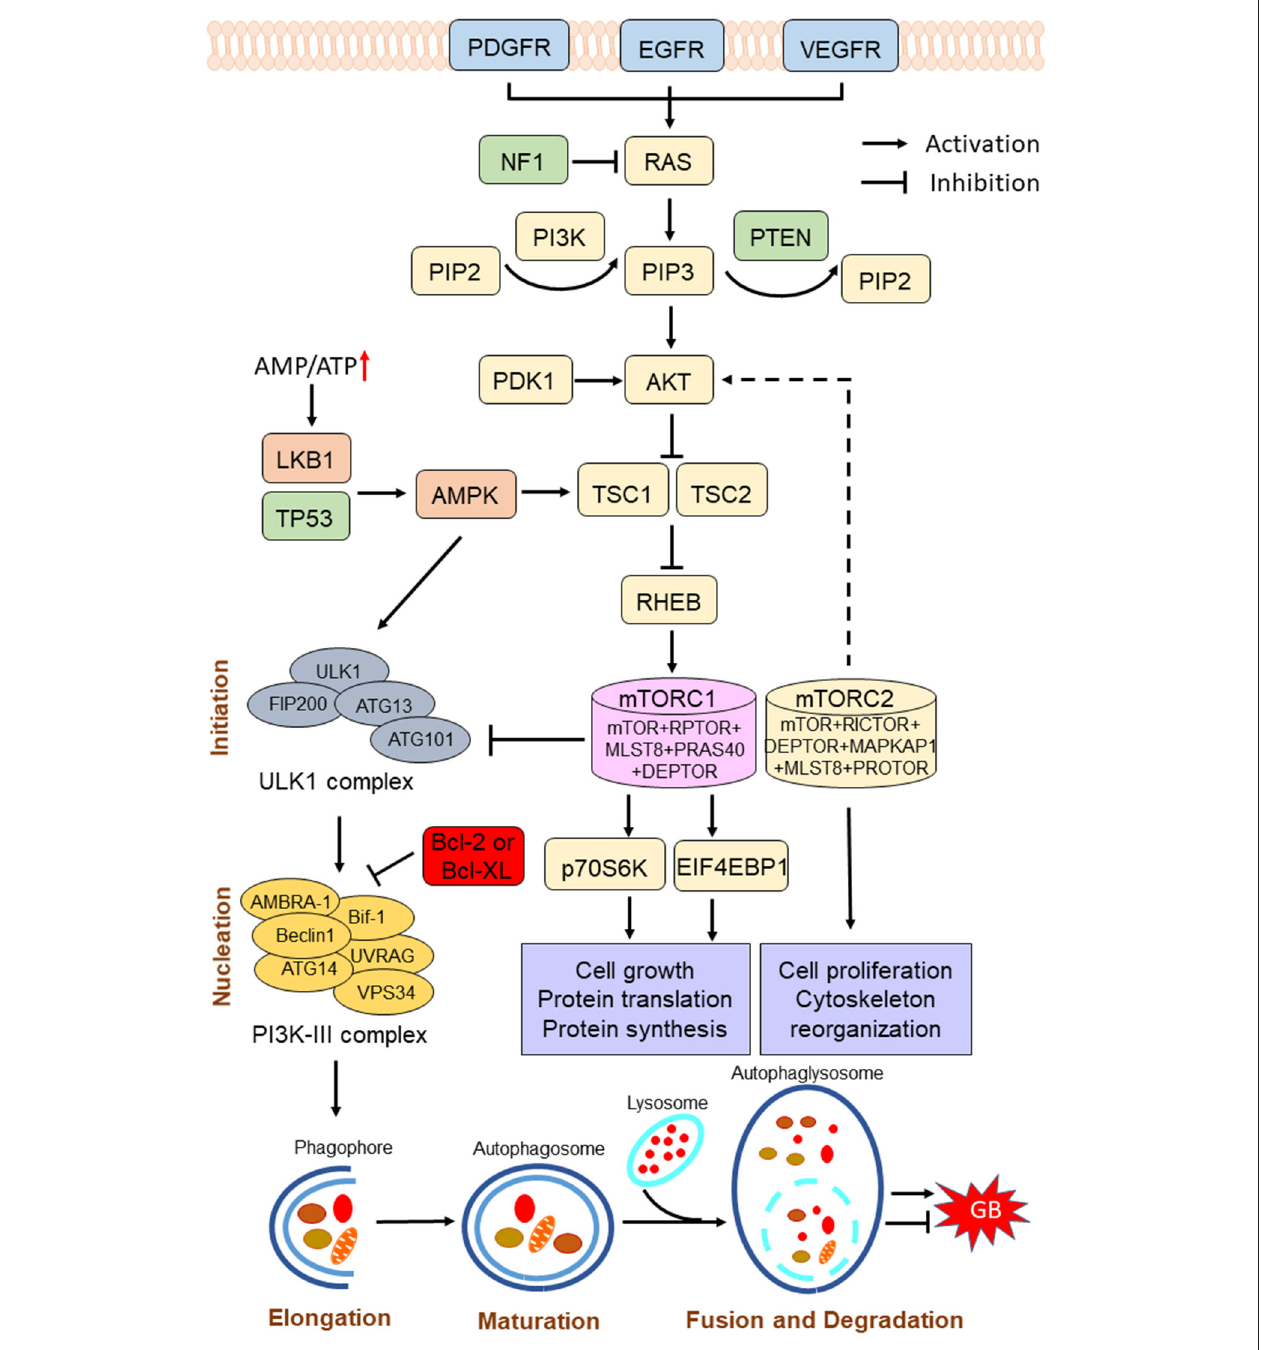
FIGURE 1 | Scheme of the phosphoinositide 3-kinase (PI3K)/protein kinase B (AKT)/mammalian target of rapamycin (mTOR) pathway in the regulation of autophagy process. The PI3K/AKT/mTOR signaling pathway is activated by various receptor tyrosine kinases (RTKs), such as epidermal growth factor receptor (EGFR), vascular endothelial growth factor receptor (VEGFR), and platelet-derived growth factor receptor (PDGFR), while the pathway is negatively regulated by phosphatase and tensin homolog (PTEN). Hyperactivation of the PI3K/AKT/mTOR pathway inhibits autophagy, and suppression of the PI3K/AKT/mTOR pathway induces autophagy. mTOR complex I (mTORC1) plays a key role in the regulation of autophagy process. Under conditions of nutrient sufficiency, mTORC1 is activated and inhibits autophagy. Under starvation or low energy, AMP-activated protein kinase (AMPK) is activated and mTORC1 is inactivated, leading to the initiation of